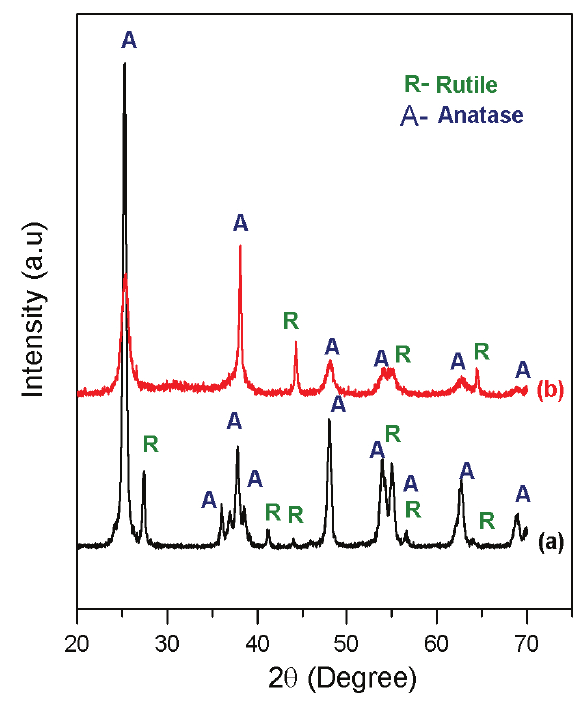
and (b) 5 % Ag-doped TiO 2